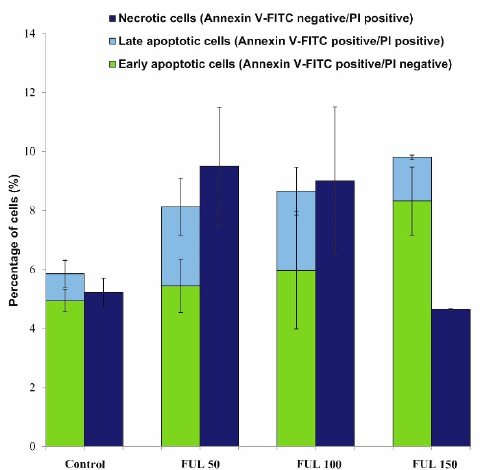
Figure 7. Cytometric analyses of cell viability for cells stained with PI and Annexin V-FITC. PBMCs were incubated in the absence or presence of fullerenol from 50 to 150 mg/L for 24 h (37 °C, 5 % CO 2 atmosphere, 100% relative humidity). The differences between control and fullerenol-treated cells were not statistically significant.